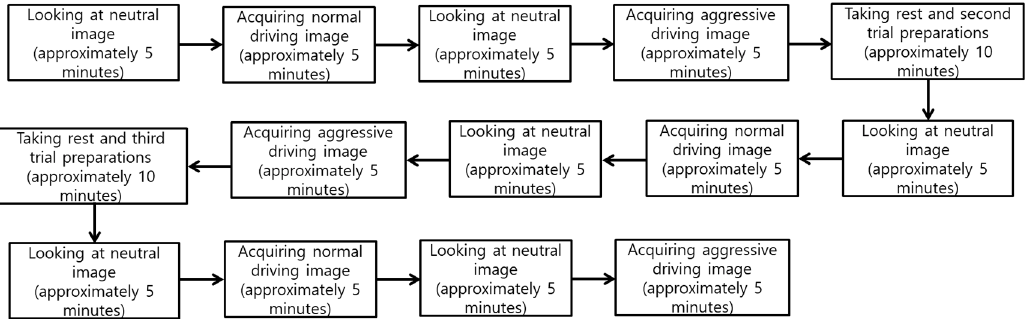
Figure 10. Steps followed during experimental procedure. Normal and smooth driving images are collected while operating euro truck simulator 2 [58] and need for speed [57] simulators respectively.